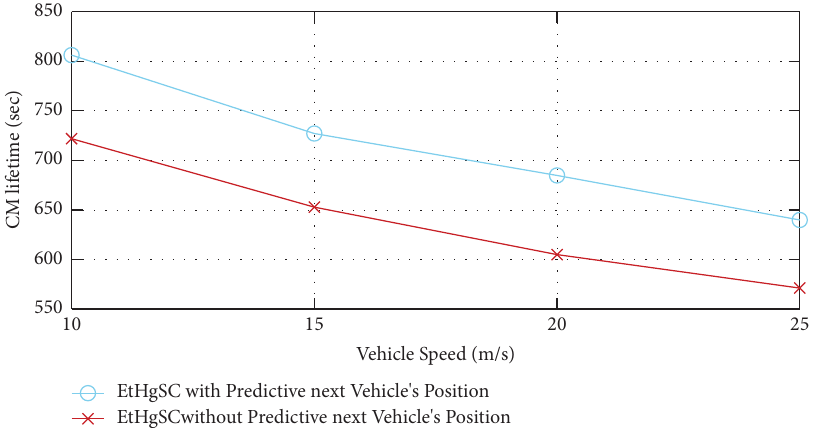
Figure 7: CM lifetimes for EtHgSC with and without predicted next vehicle’s position.